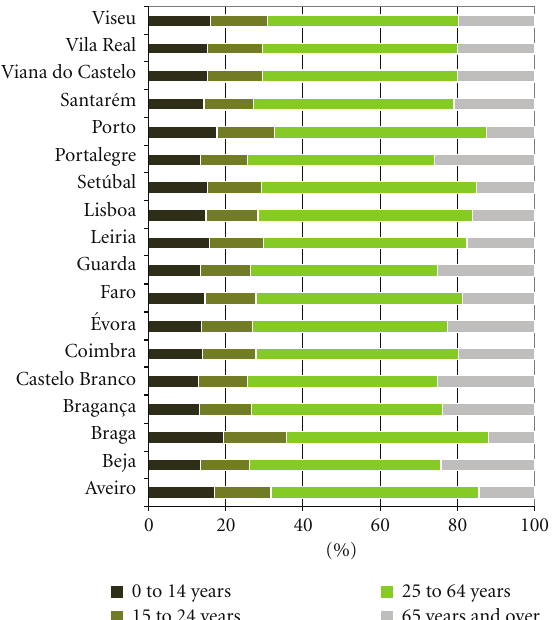
Figure 4: Distribution of population by age group for each Por- tuguese district in 2001.